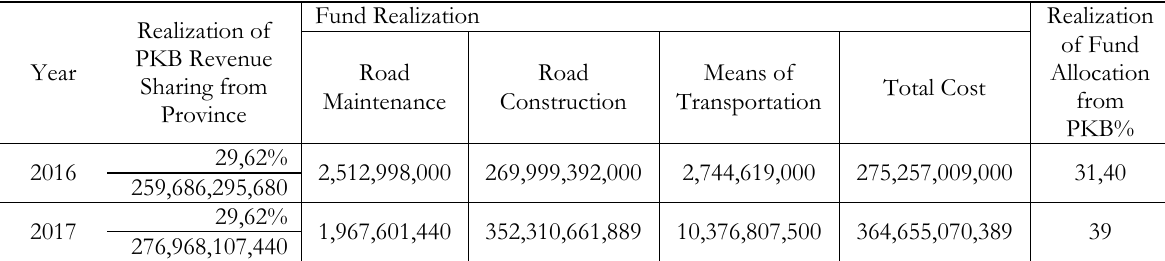
Realization of Transportation Agency's Budget of Bekasi City